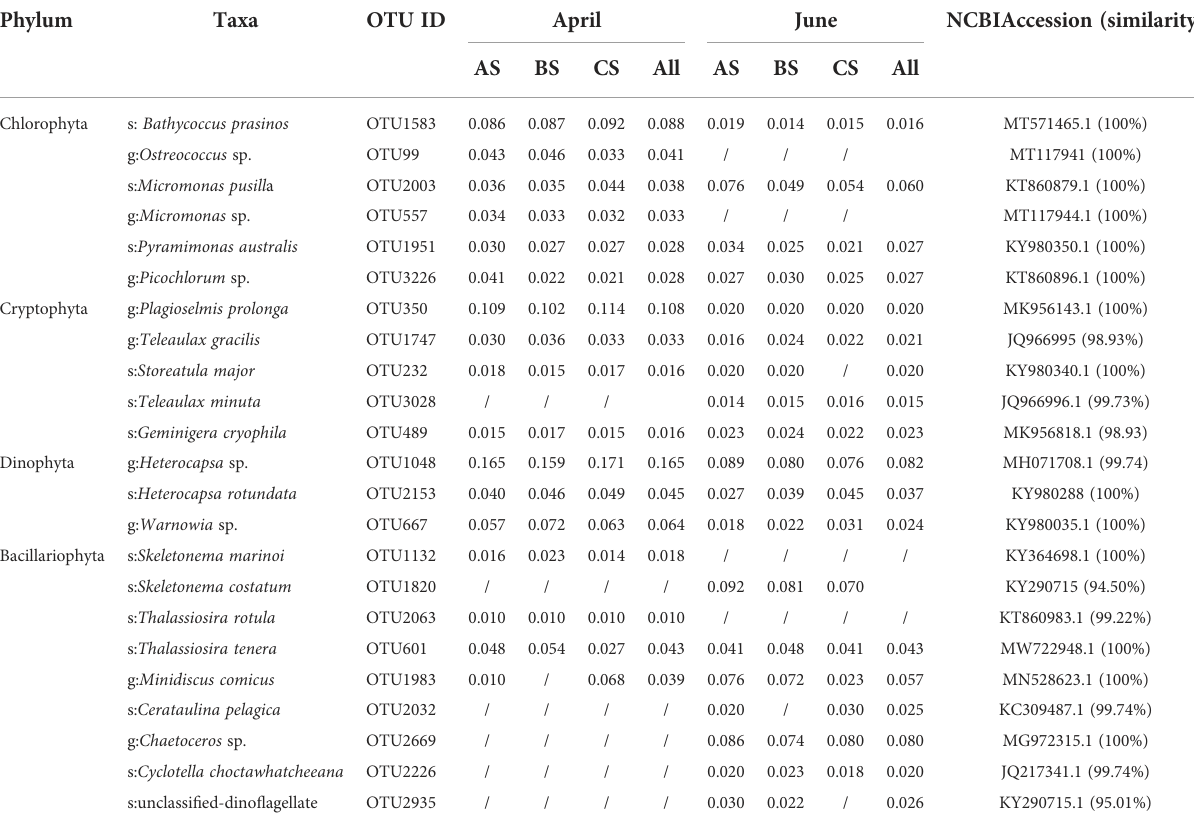
TABLE 3 Dominant genera and species based on high throughput sequencing, in addition to their dominance values and sequence similarity to database accessions.